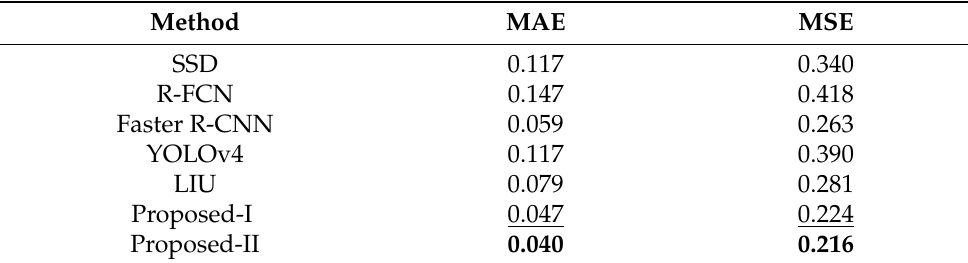
Table 7. Comparison of insect pest counting performance on the testing set for SSD, R-FCN, Faster R-CNN, YOLOv4, LIU, Proposed-I and Proposed-II, where values in bold and underlined denote the best and second best values,